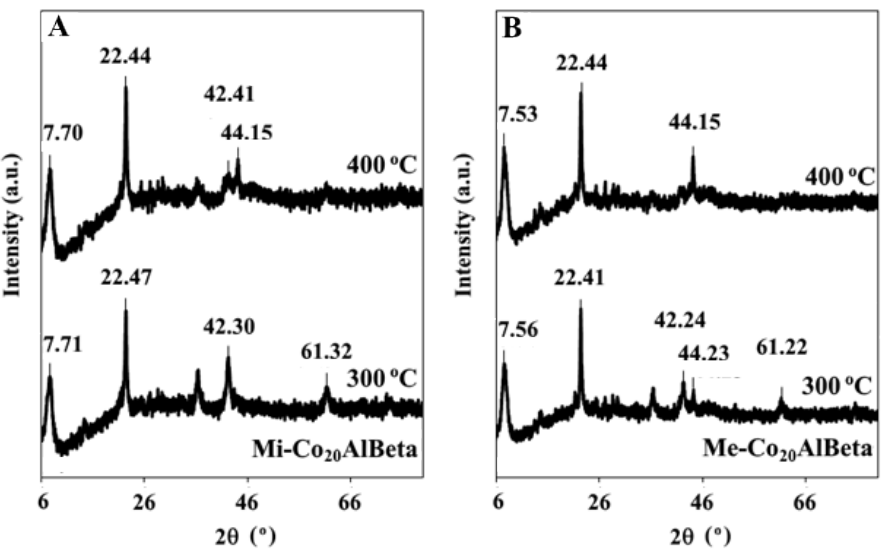
Figure 2. In situ XRD patterns recorded in situ at 300 and 400 ◦ C measured in the atmosphere of the mixture of 5 vol % hydrogen in argon ( A ) Mi-Co 20 AlBeta and ( B ) Me-Co 20 AlBeta.